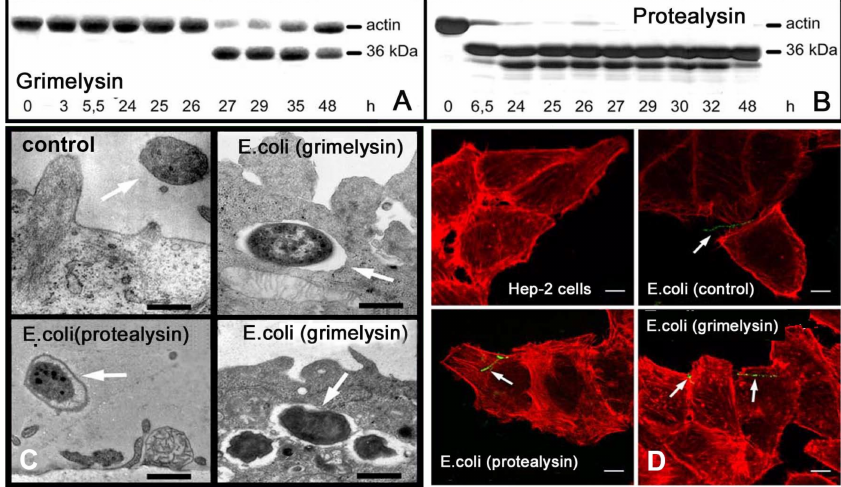
Figure 3. Actinase activity of recombinant E. coli transformed with the grimelysin or protealysin gene. ( A , B ) Detection of the actinase activity in the lysates of the recombinant E. coli expressing grimelysin or protealysin. Numbers indicate the time points of bacteria culturing when their extracts were tested for actinase activity [21]. ( C , D ) Invasion of human larynx carcinoma Hep-2 cells by recombinant E. coli expressing the grimelysin or protealysin gene, observed by electron ( C ) and confocal ( D ) microscopy [21]. Arrows indicate extracellular and internalized bacteria. By electron microscopy, bacteria are in vacuoles ( C ) that are not visible with confocal microscopy. Scale bars, 1 µ m. ( D ) The samples were examined under a Leica TCS SL confocal scanning microscope using a dual argon ion (488 nm; green fluorescence) and helium / neon (543 nm; red fluorescence) laser system to visualize the FITC-stained bacteria and rhodamine phalloidin stained cytoskeleton, respectively. Scale bars, 1 µ m ( C ) and 10 µ m ( D ). Modified from [21] with permission from Wiley license 4827670496420, 2020.